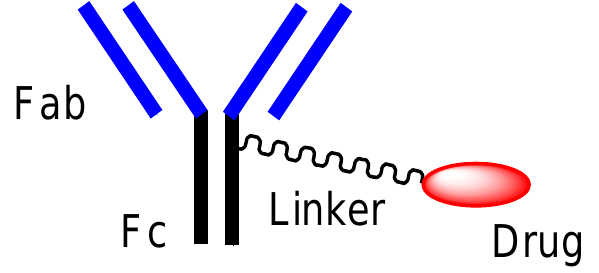
Figure 1. The structure of canonical antibody – drug conjugate (ADC).